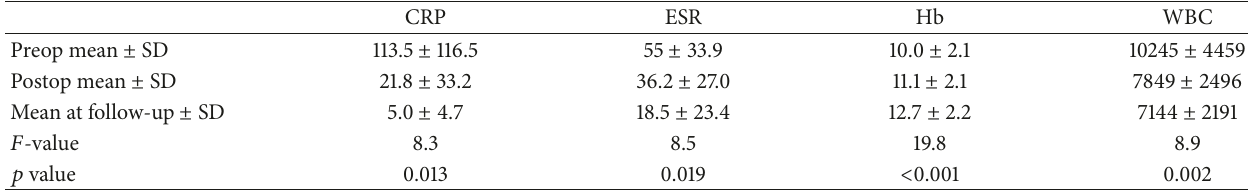
Table 4: Summary table containing the means at the three data collection points, their standard deviations, and the relevant 𝐹 -value and 𝑝 value for each biochemical